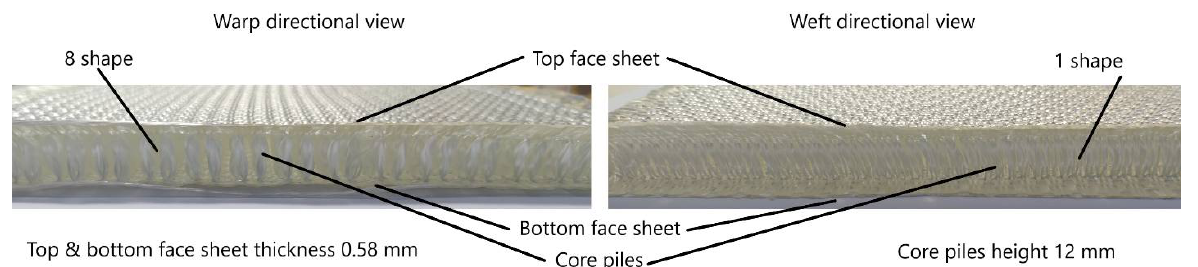
Figure 1. Three-dimensional integrated woven spacer fabric.